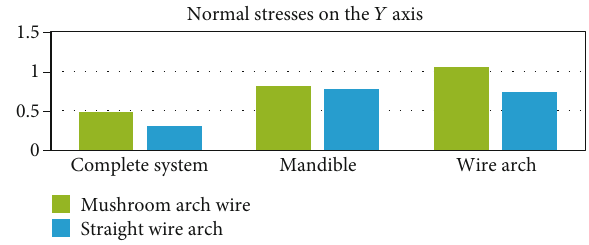
Figure 25: Normal stresses in the Y axis (MPa). The graph shows a comparison between the stresses in the Y axis that were generated in each of the analyzed sections: complete system (mandibular bone, dental organs, brackets, and wires) and separately the mandible and the two di ff erent types of arches or wires.